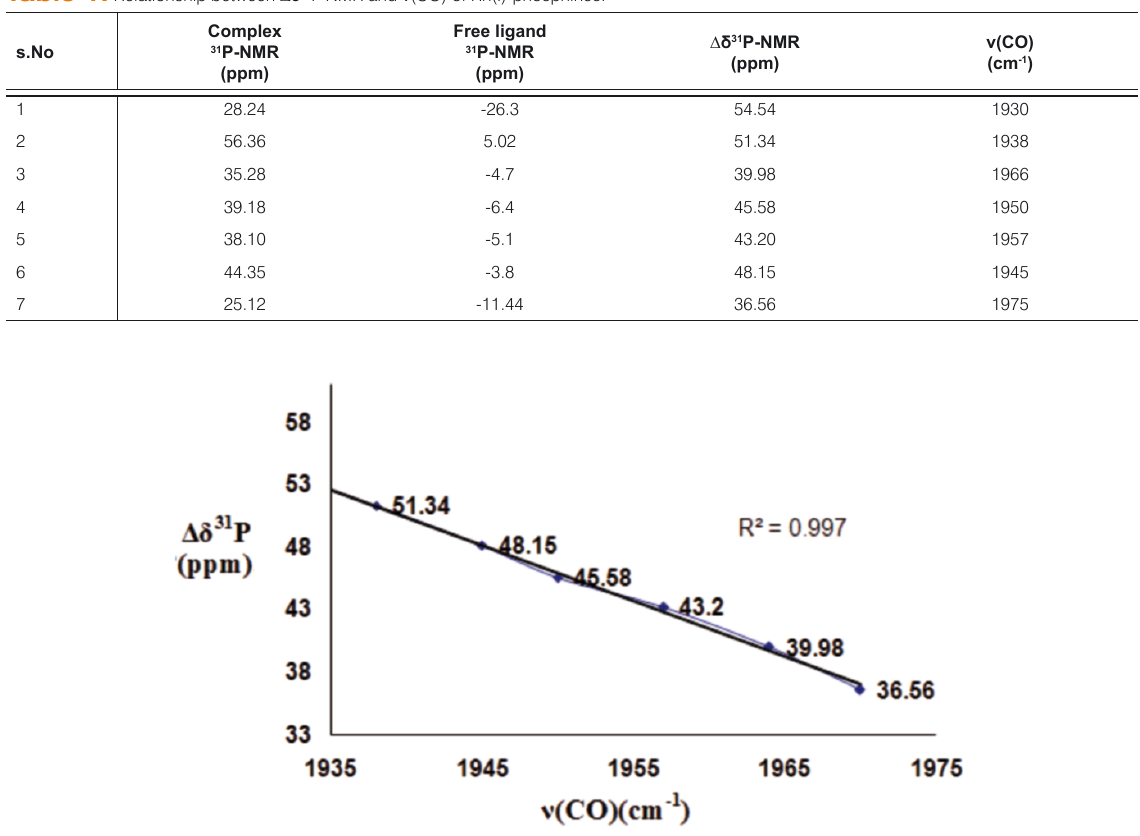
Figure 2. Relationship between Δδ 31 P(ppm) and ν (CO)(cm -1 ) of Rh(I)-phosphines 1 -